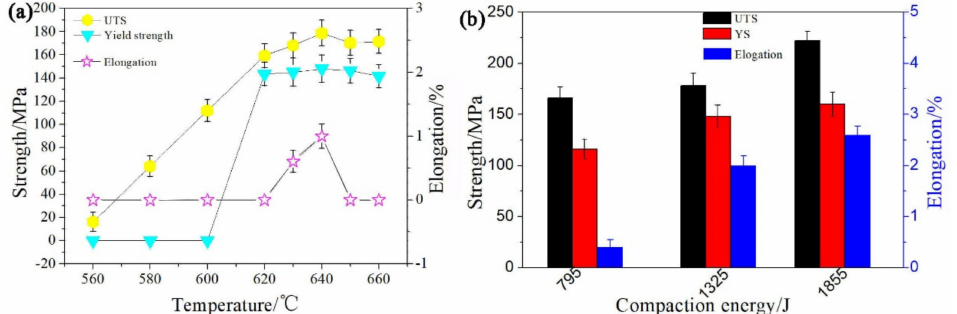
Figure 10. Ultimate tensile strength (UTS), yield strength (YS) and elongation versus sintering temperature ( a ); UTS, YS and elongation versus compaction energy ( b